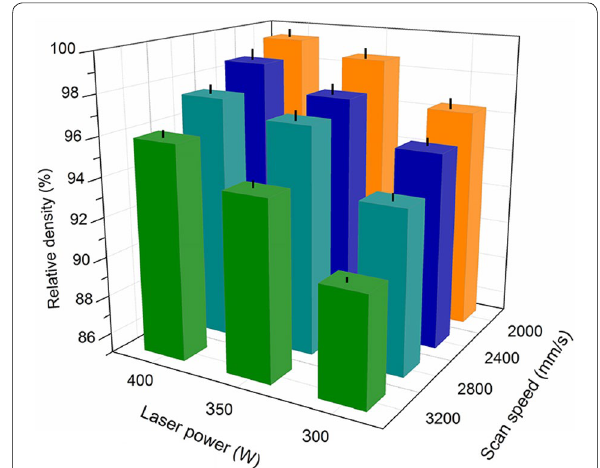
Figure 3 Relative densities of SLM-processed TiB 2 /AlSi10Mg composite parts with different process